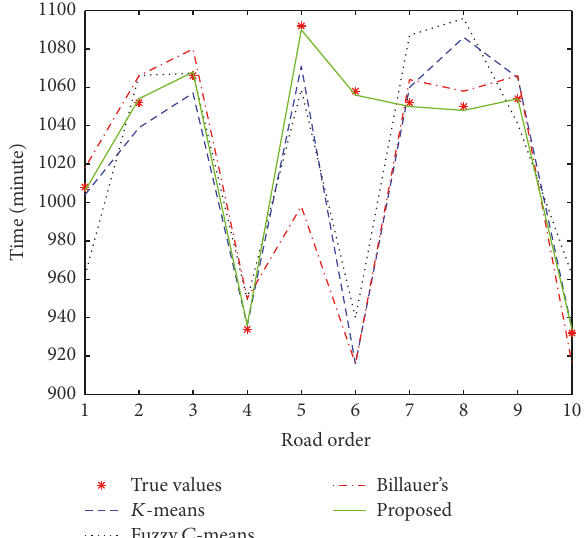
Figure 9: Performance comparison of four methods for evening peak period